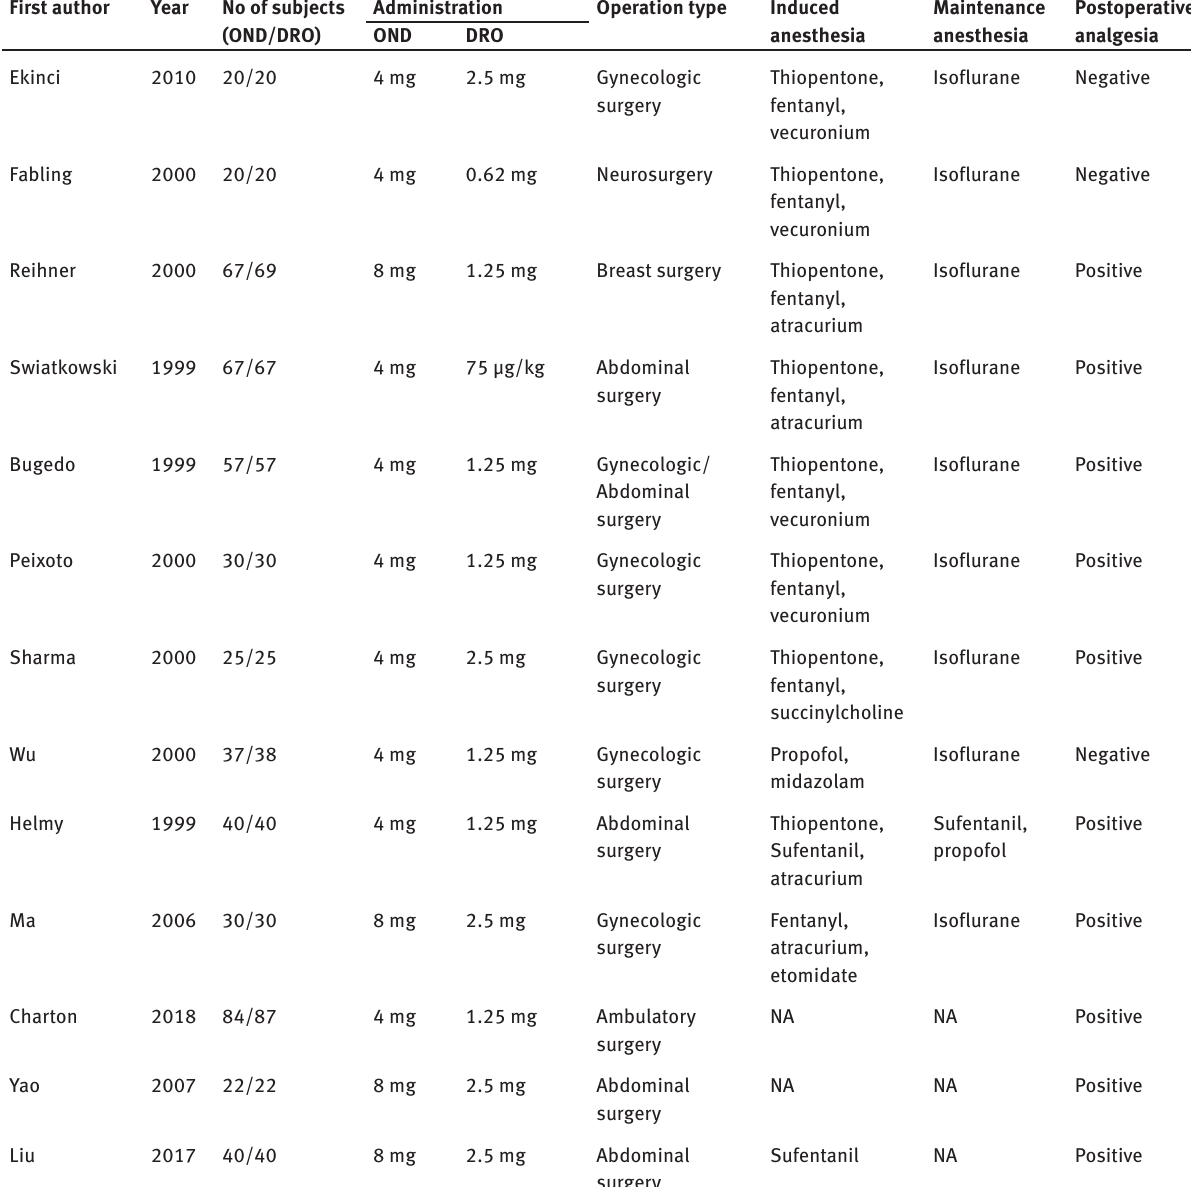
Table 1: The main features of the included clinical trials